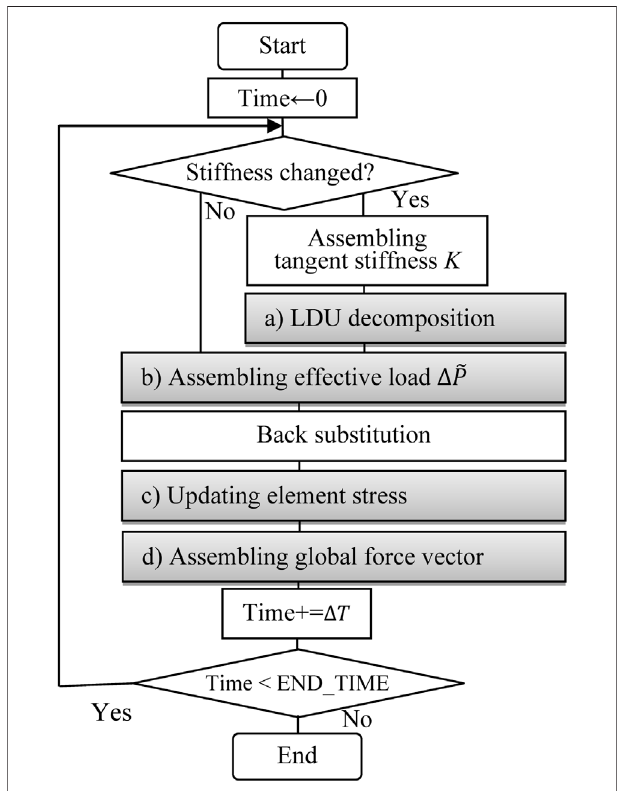
FIGURE 3 | Program fl